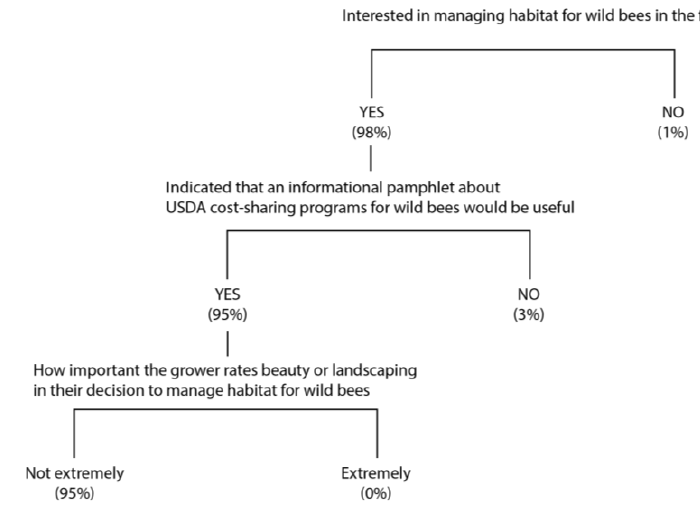
Figure 5. A classification tree that predicts whether growers are interested in participating in a cost-share program for wild bees in the future (Q39). The numbers below each branch indicate the percentage of respondents within each group.